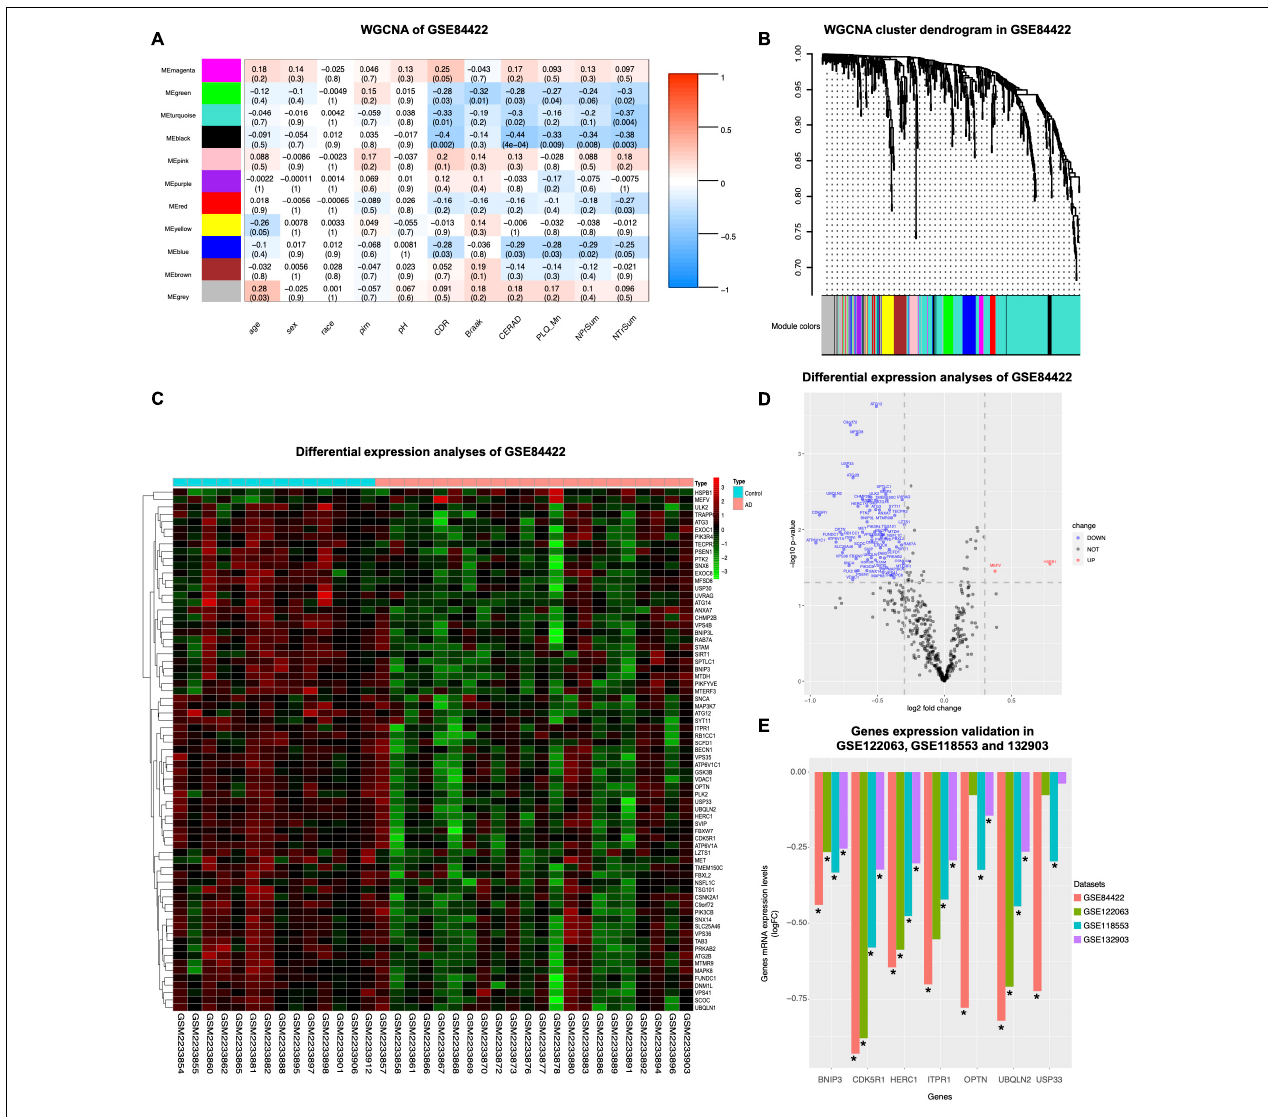
FIGURE 2 | WGCNA coexpression analysis and differential expression analysis. GSE84422 (Wang et al., 2016) was used to perform WGCNA. (A) The correlation between each module and clinical phenotypes is shown, including 11 modules and 11 clinical phenotypes. In each unit, the numbers above show the correlation, and the numbers below show the p -value. Abbreviations: CDR, clinical dementia rating; Braak, Braak NFT score; CERAD, CERAD diagnoses and ratings of pathology; PLQ_Mn, average of neuritic plaque counts in five cardinal cortical regions; NPrSum, sum of CERAD semiquantitative rating scores for all cortical regions examined neuropathologically; NTrSum, sum of semiquantitative NFT density ratings for all cortical regions examined. (B) Cluster dendrogram of the coexpression network modules was produced based on the autophagy genes, including 11 modules. (C) DEGs in healthy control and AD in GSE84422 were shown in the heatmap. Cut-off criteria for screening DEGs were p < 0.05 and | log2fold change| ≥ 1.3. (D) Autophagy genes with significantly different expression in GSE84422 were shown in the volcano plot. Red spots indicate upregulated genes, and blue spots indicate downregulated genes. Cut-off criteria for screening DEGs were p < 0.05 and | log2fold change| ≥ 1.3. (E) Validation of the gene expression levels of BNIP3, CDK5R1, HERC1, ITPR1, OPTN, UBQLN2, and USP33 between healthy control and AD was shown in three other datasets, GSE122063 (McKay et al., 2019), GSE118553 (Patel et al., 2019), and GSE132903 (Piras et al., 2019). Y-axes in the left indicate log2fold change of the screened seven genes in each dataset. Significant differences (AD versus control expression levels) were performed, * p < 0.05 compared with the control